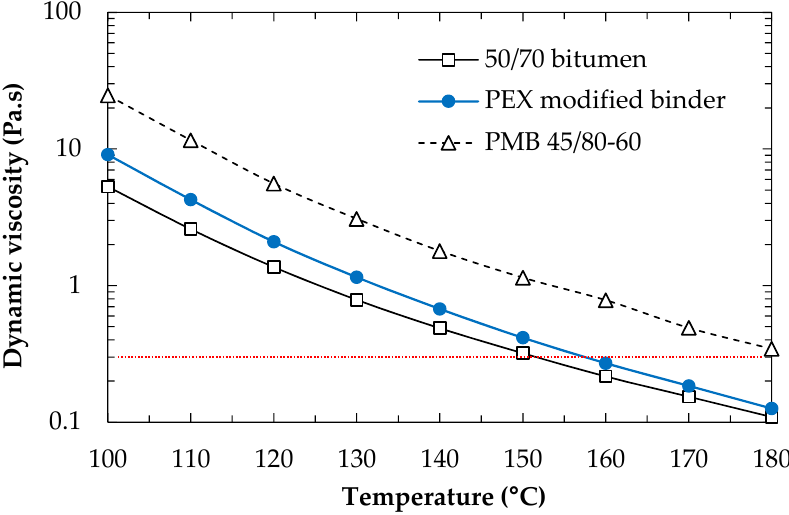
Figure 7. Dynamic viscosity results of the asphalt binders used in this study, including the PEX modified binder.